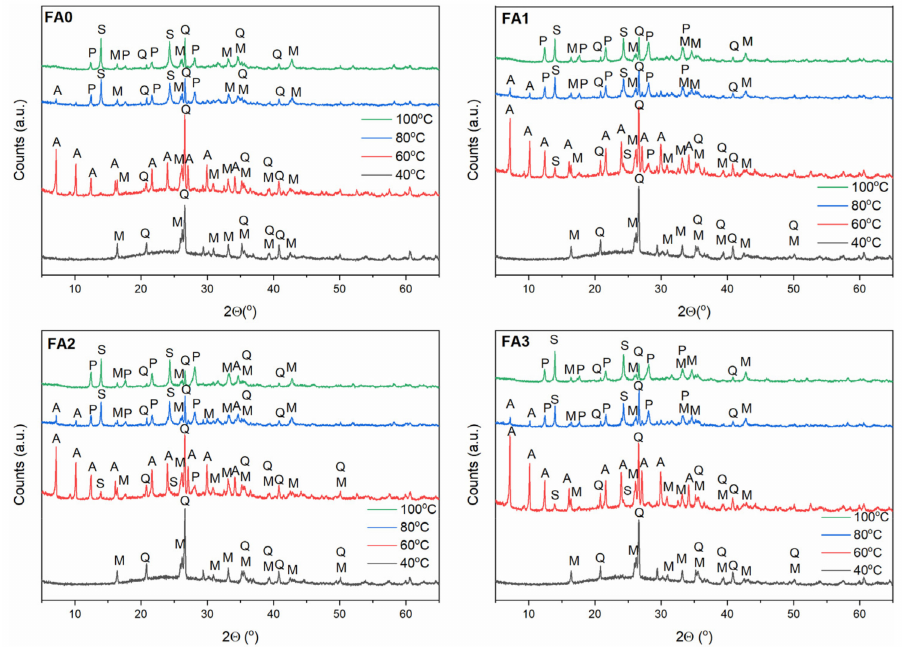
Figure 4. The effect of FA milling and temperature on FA conversion into Na-A zeolite